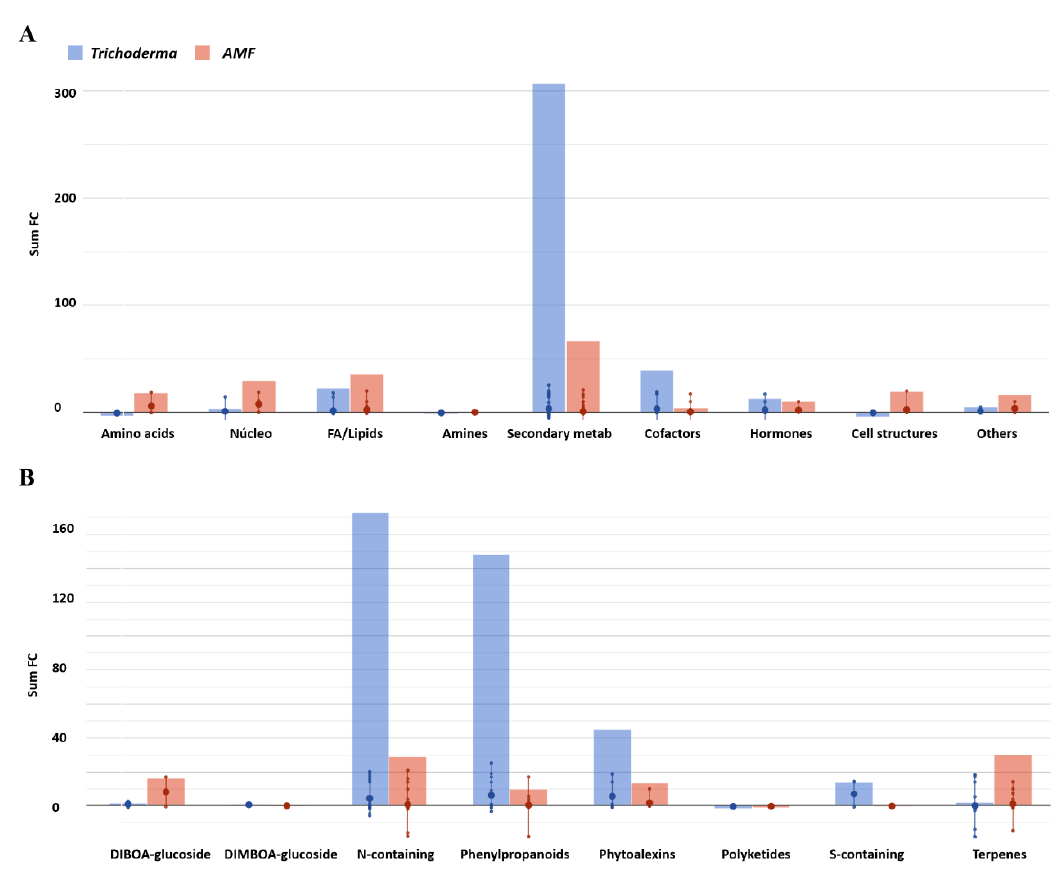
Figure 3. Metabolic processes ( A ) and secondary metabolite biosynthesis ( B ) were impaired in tomato leaves as a result of the treatments. The metabolomics dataset produced through UHPLC-ESI/QTOF-MS was subjected to ANOVA followed by a fold-change (FC) ( p < 0.05, FC ≥ 1.5), and differential metabolites were loaded into the PlantCyc Pathway Tool (https://www.plantcyc.org/, accessed on 18 April 2020). The x -axis represents each set of metabolic subcategories, while the y -axis corresponds to the cumulative log FC. The large dots represent the average (mean) of all FCs for the different metabolites in the class, while the small dots represent the individual log FC.